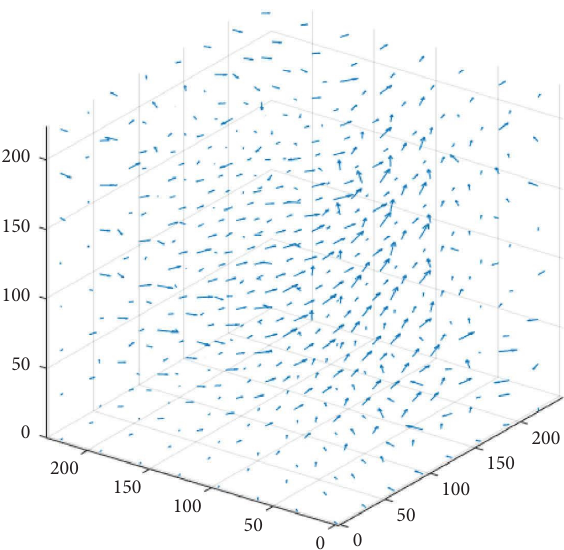
Figure 2: Tree-dimensional current map.